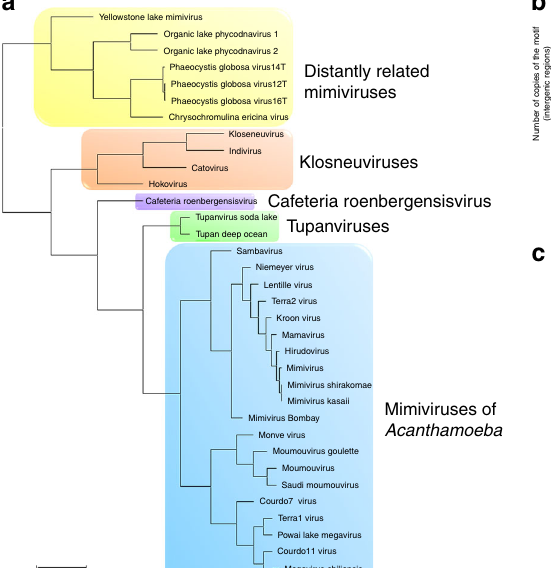
Fig. 2B, C, 3 and 7; Supplementary Datas 3 and 4). Tupanvirus